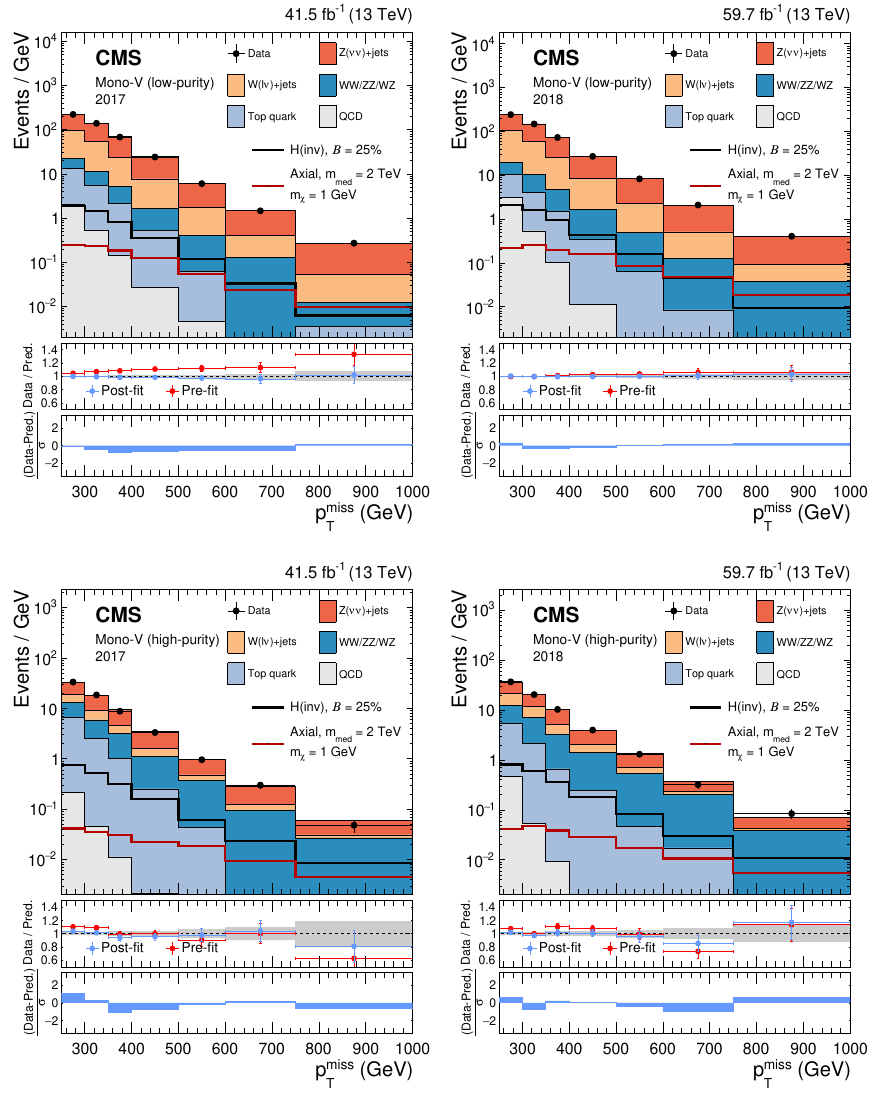
Figure 5 . Comparison between data and the background prediction in the mono-V signal regions before and after the simultaneous fit. The fit includes all control regions and the signal region in all categories and both data taking years, and the background-only fit model is used. The resulting distributions are shown separately for 2017 (left column) and 2018 (right column), as well as for the low- and high-purity categories (upper and lower rows, respectively). Templates for two signal hypothesis are shown overlaid as black and dark red solid lines. The last bin includes the overflow. In the middle panels, ratios of data to the pre-fit background prediction (red solid points) and post-fit background prediction (blue solid points) are shown. The gray band in the middle panels indicates the post-fit uncertainty after combining all the systematic uncertainties. Finally, the distribution of the pulls, defined as the difference between data and the post-fit background prediction divided by the quadratic sum of the post-fit uncertainty in the prediction and statistical uncertainty in data, is shown in the lower